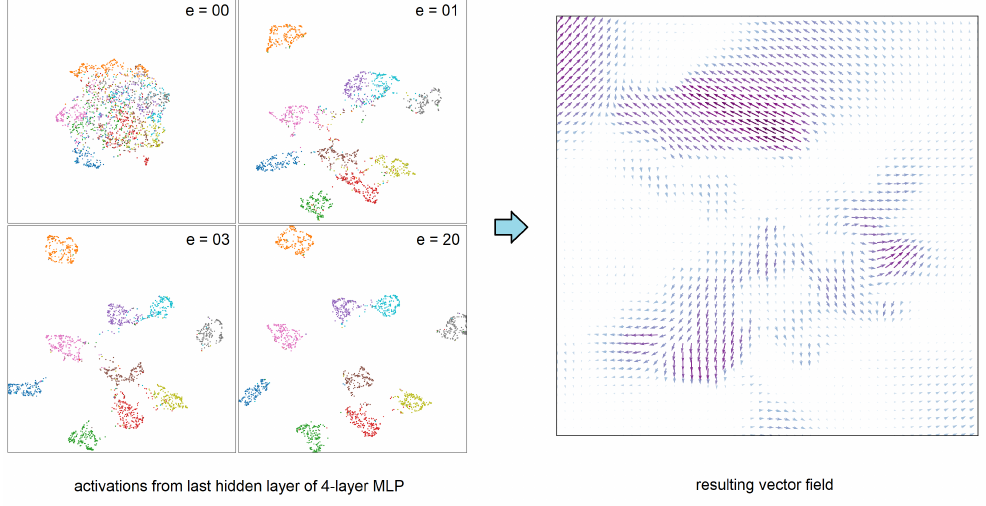
Figure 3. Outputs from the last hidden layer of a 4-layer MLP were gathered during training, after 0, 1, 3, and 20 epochs. Projected data refer to a sample of MNIST test set, with 2000 instances. Instance projected position at each epoch define trajectories that were used to approximate vector fields, as shown on the right side of the figure. A clear expansion pattern can be observed, as instances move outwards to form groups as the network is